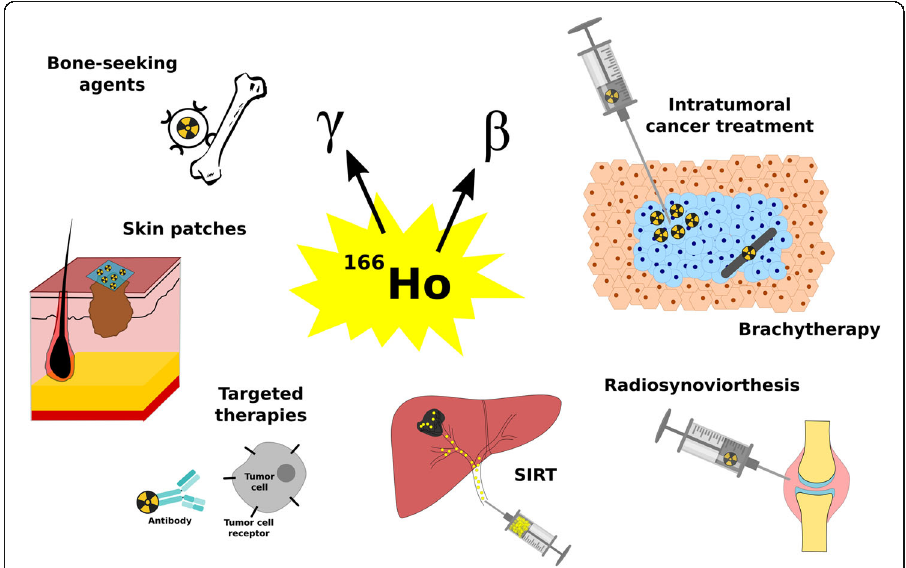
Fig. 3 Schematic overview of medical applications of the isotope 166